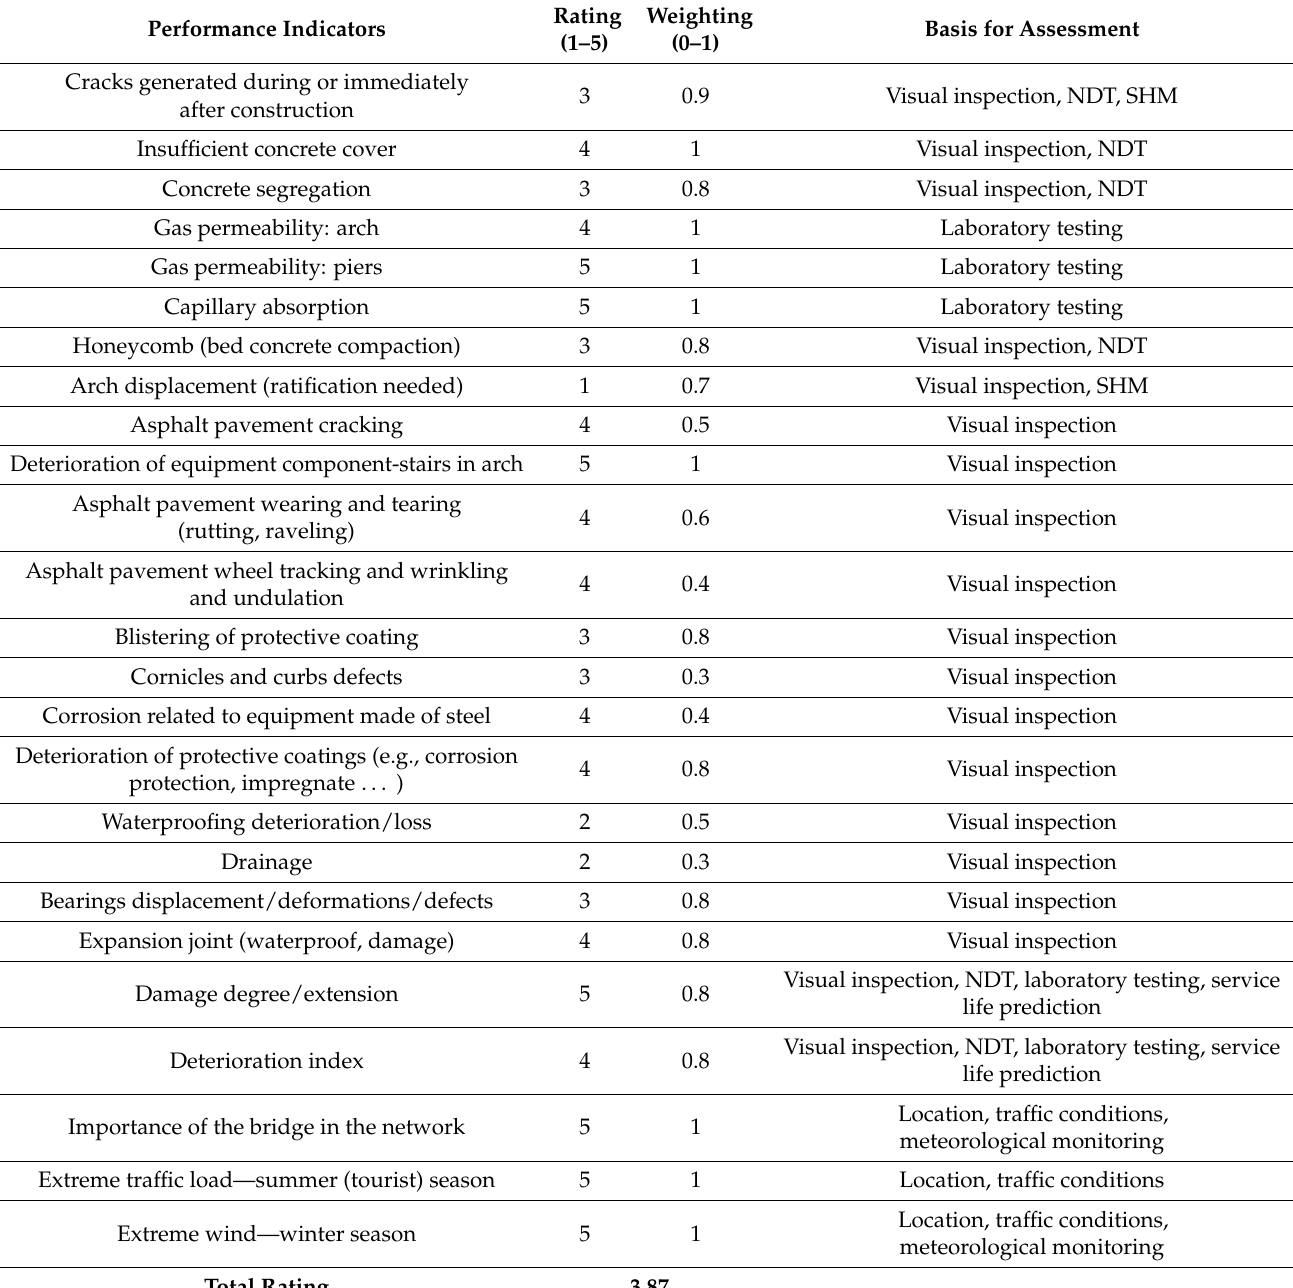
Table 9. Assessment of key performance indicators related to availability and